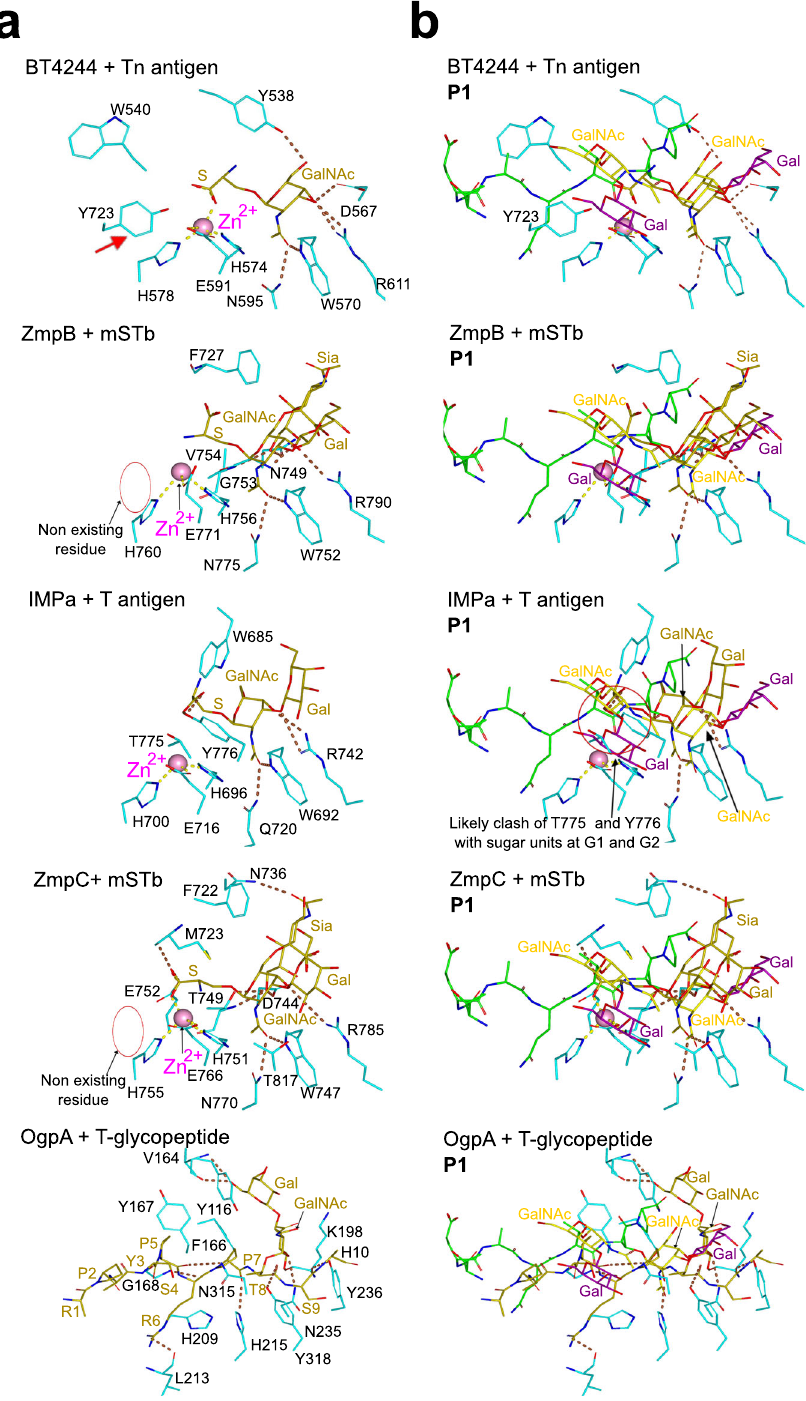
Fig.6|AnalysisofBT4244,ZmpB,IMPa,ZmpC,OgpA,andAM0627activesites. a Close-up view of the active sites of BT4244-Tn O -glycan, ZmpB,-mSTb, IMPa-T O - glycans, ZmpC-mSTb, and OgpA-T-glycopeptide complexes. Note thatthe zinc ion isnotpresentinthestructureofOgpAincomplexwiththeT-glycopeptidebecause an inactive version of OgpA was used in which the His205, a residue that coordi- nates the Zn 2+ , and the catalytic Glu206 was mutated to Ala 20 . The ligands and the Zn 2+ in these structures are shown as olive carbon atoms and as a pink sphere, respectively.Theaminoacidsoftheenzymesareshownascyancarbonatoms.The